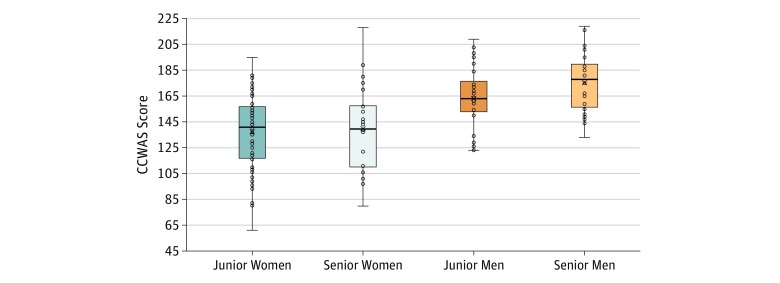
Median Scores on the Culture Conducive to Women’s Academic Success (CCWAS) by Respondents’ Gender and Years in PracticeScores on the CCWAS range from 45 to 225, with higher scores indicating that the respondent perceives the culture as more favorable to women. The horizontal lines indicate the median CCWAS score, the upper box includes the median to 75th percentile, and the lower box includes the 25th percentile to the median. The whiskers indicate the maximum and minimum CCWAS scores, and circles represent individual CCWAS responses. Junior indicates physicians with 15 or less years of work experience; senior, physicians with more than 15 years of work experience.